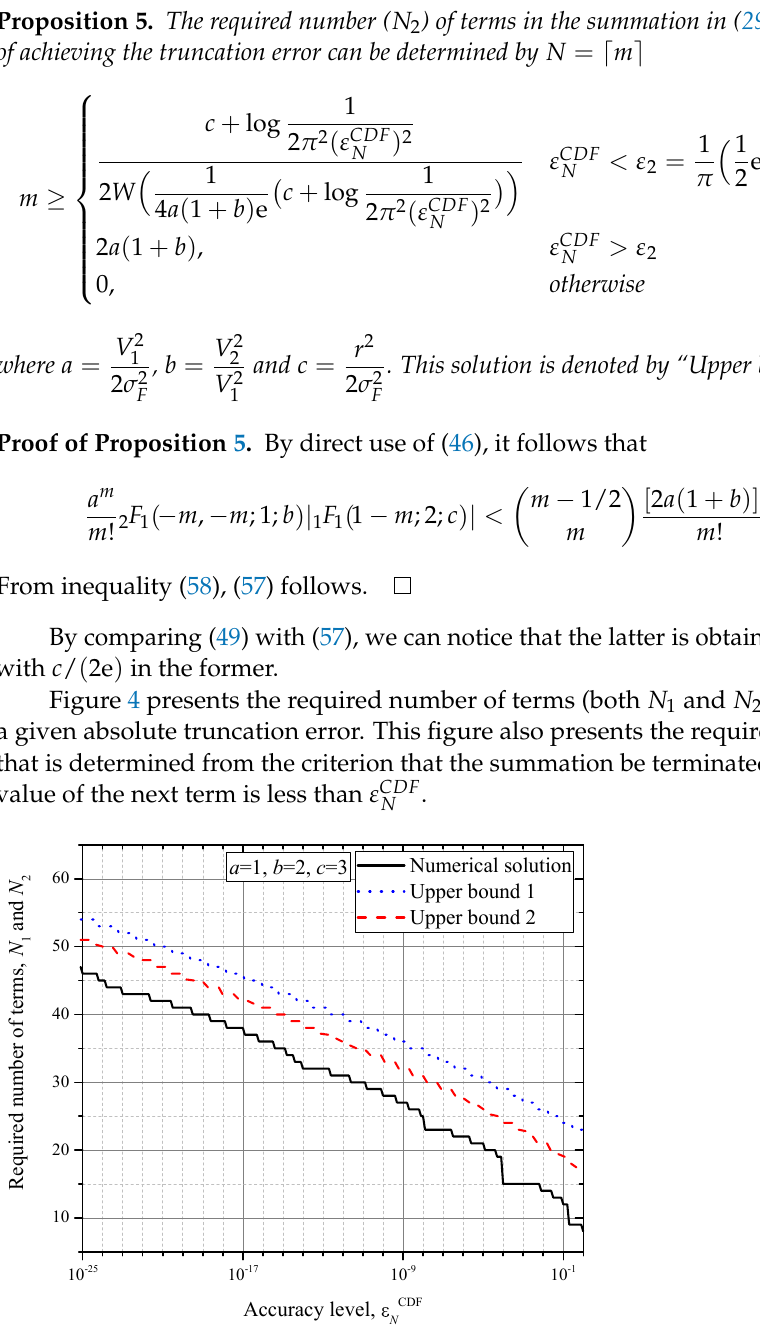
Figure 4. Illustration of the required number of terms in the summation in the CDF to achieve a specified absolute truncation